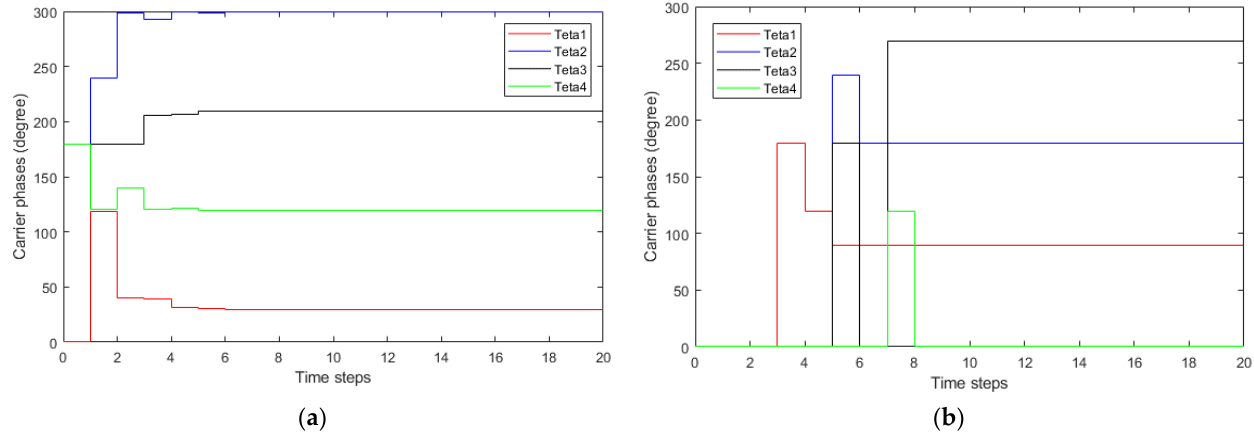
Figure 22. Configuration process of a converter with four-carriers, startup with ( a ) conventional modified updating rule; ( b ) proposed DSA-PSC.